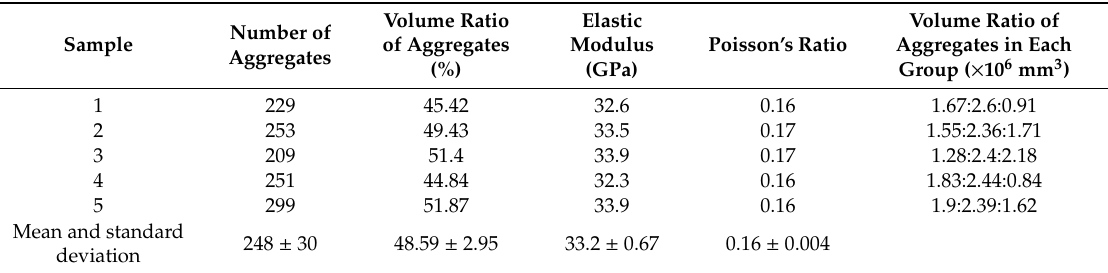
Table 8. A summary of aggregate parameters and calculated elastic constants of samples randomly cut from the same concrete